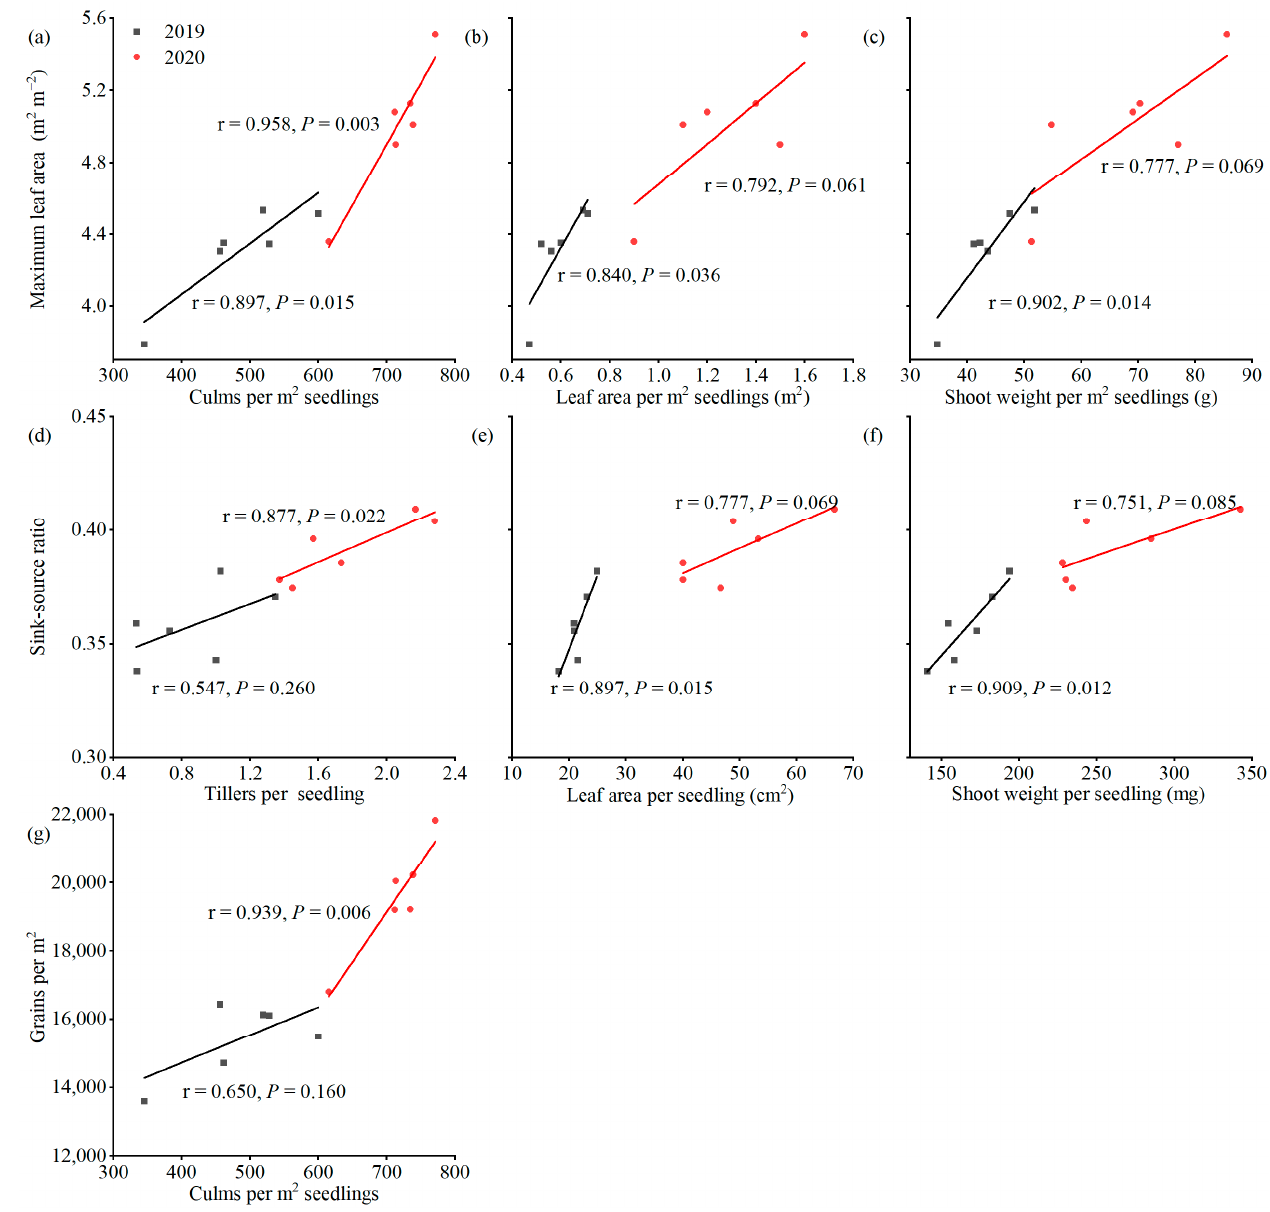
Figure 4. Relationships of ( a – c ) culms, leaf area, and shoot weight per m 2 seedlings with maximum leaf area, ( d – f ) tillers, leaf area, and shoot weight per seedling with sink–source ratio, and ( g ) culms per m 2 seedlings with grains per m 2 under different treatments in the growth seasons of